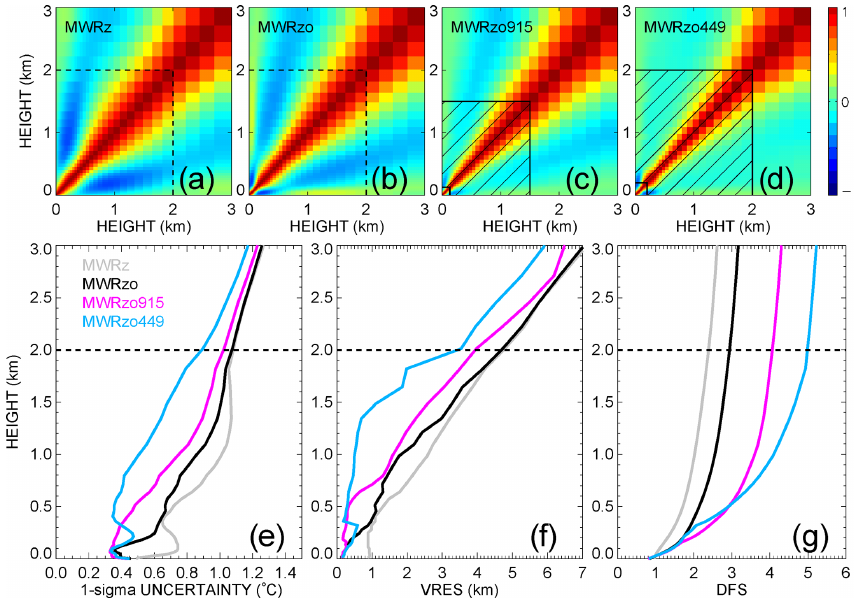
Figure 4. (a–d) The mean S op s, displayed as correlation matrices, for (a) MWRz, (b) MWRzo, (c) MWRzo915, and (d) MWRzo449, averaged over all radiosonde events. The hatched area in panels (c) and (d) marks the RASS maximum measurement heights. (e) One-sigma uncertainty derived from the posterior covariance matrix in ◦ C, (f) vertical resolution (VRES) in kilometers, and (g) cumulative degree of freedom (DFS) as a function of height for temperature, averaged over all radiosonde events (MWRz is in gray, MWRzo is in black, MWRzo915 is in magenta, and MWRzo449 is in light blue). Dashed lines mark 2kma.g.l. in all